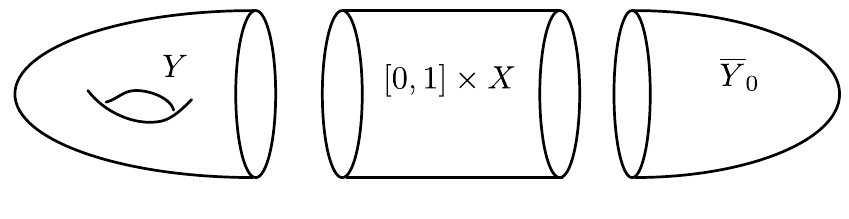
Figure 2 . Gluing three manifolds Y , [0 , 1] × X and Y 0 to get a closed manifold Y total